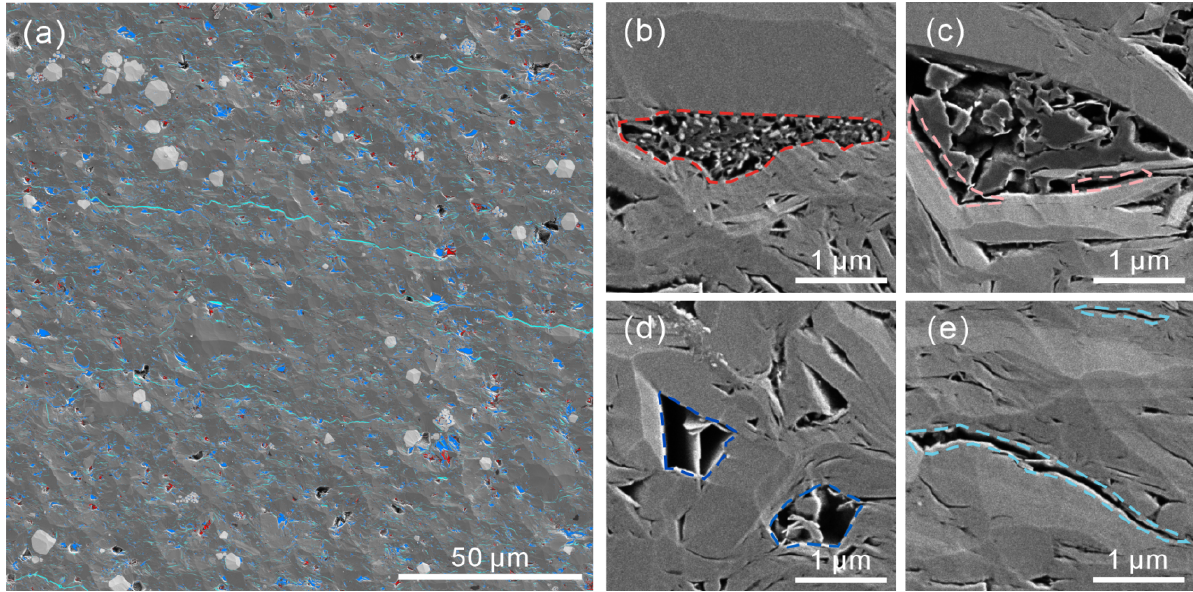
Figure 4. ( a ) The result of REA with resolution of 9.3 nm, ( b ) organic pores; ( c ) organic cracks, Figure4. (a) The result of REA with resolution of 9.3nm, (b) organic pore; (c) organic crack, (d) inorganic ( d ) inorganic pores, ( e ) inorganic cracks. (Red areas are organic pores, pink areas are organic cracks, pore, (e) inorganic crack (Red areas are organic pores, pink areas are organic cracks, deep blue areas deep blue areas are inorganic pores, light blue areas are inorganic are inorganic pores, light blue areas are inorganic cracks ).